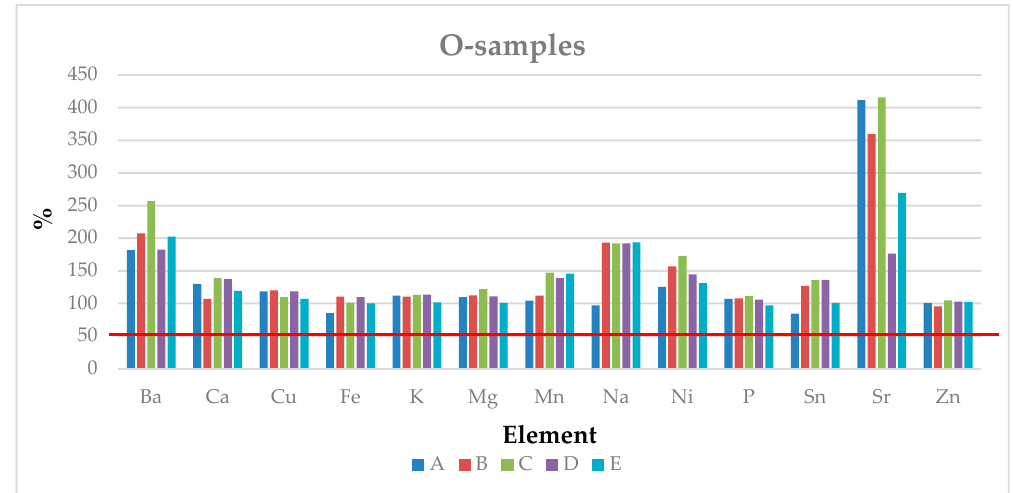
Figure 1. Concentration (%) of each element in the O-samples after four months of storage following the different methods (A–E), expressed with respect to T0 (100%).